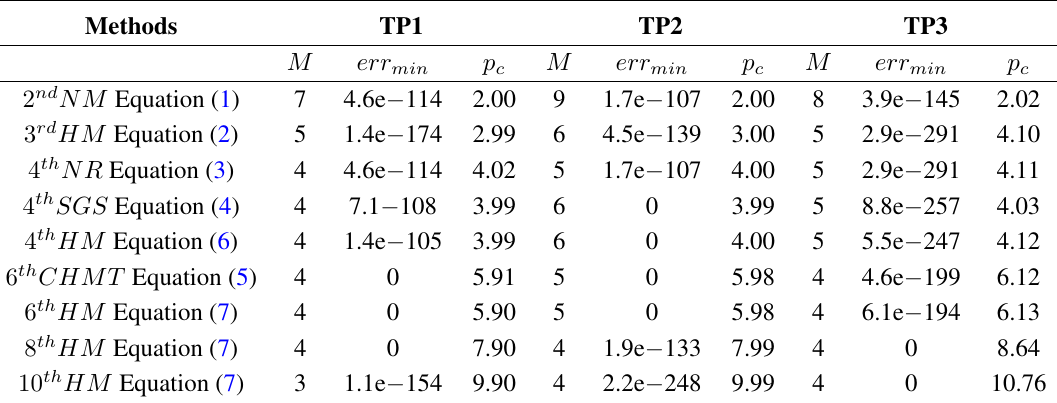
Table 1. Comparison of different methods for system of nonlinear equations.